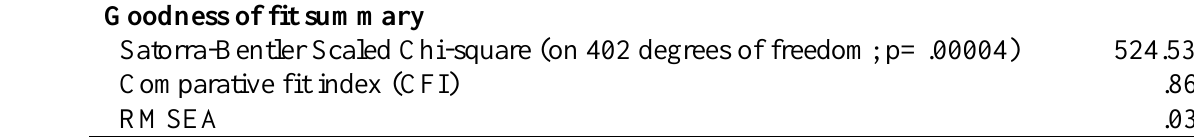
Results for the 3-factor Model of Reading Ability Goodness of fit